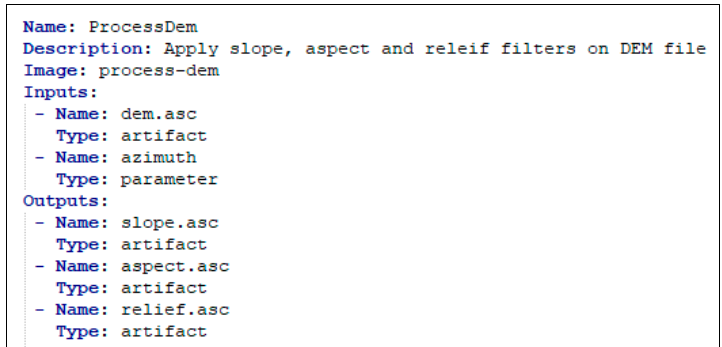
Figure 3. An example task definition.